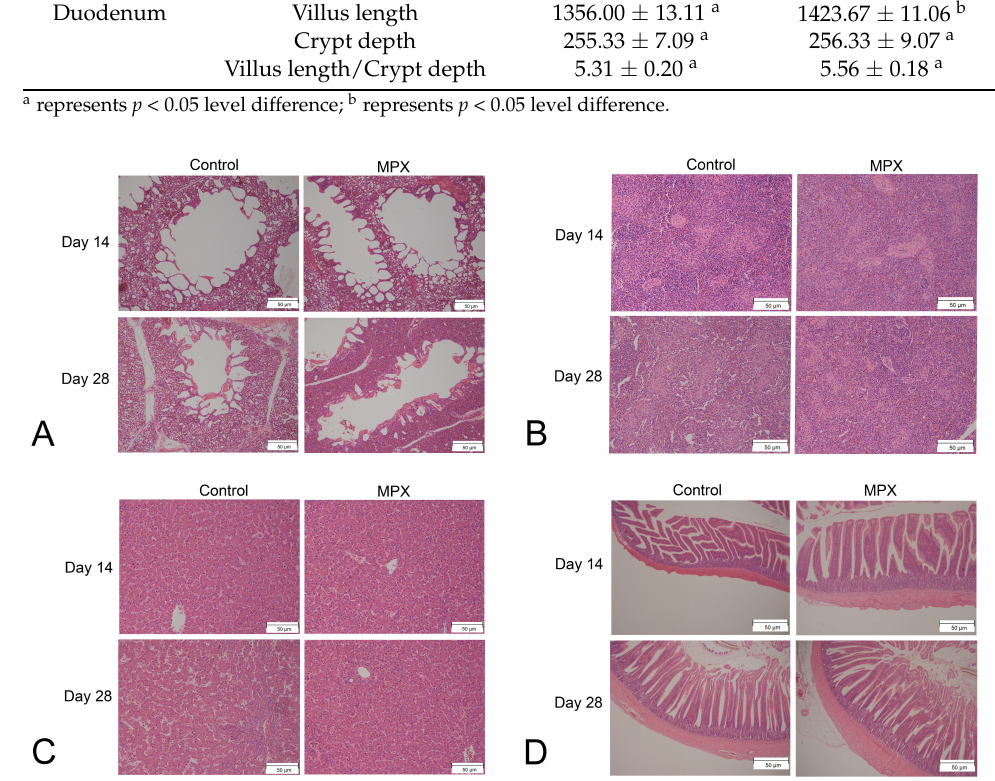
Figure 2. H&E staining was performed to observe the effects of MPX on the viscera and intestine. ( A ) H&E staining of the lung at 14 and 28 d. ( B ) H&E staining of the spleen at 14 and 28 d. ( C )